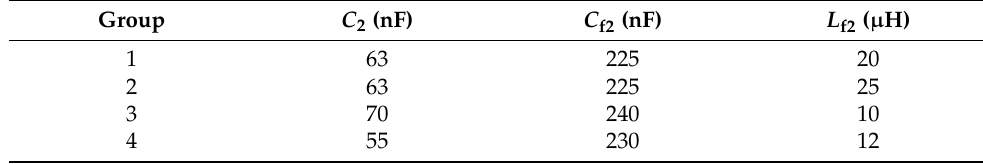
Table 4. Multi group compensation network parameters.